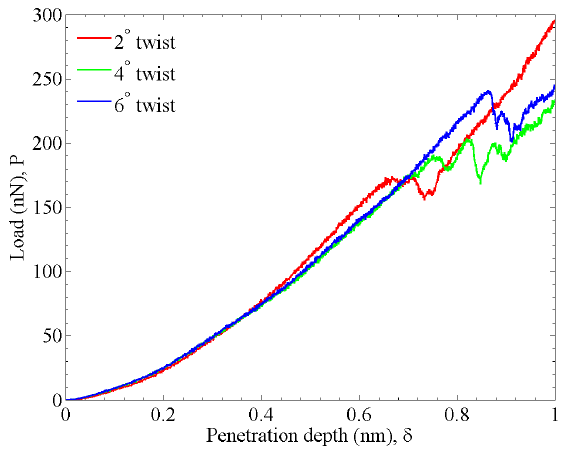
Figure 3. Load-displacement curves for the nanoindentation near the low angle twist boundaries in Al.